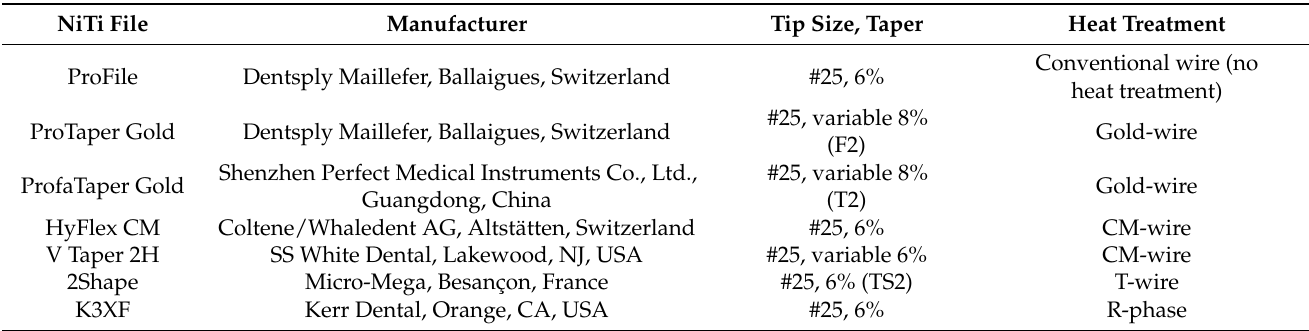
Table 1. NiTi files evaluated in this study.